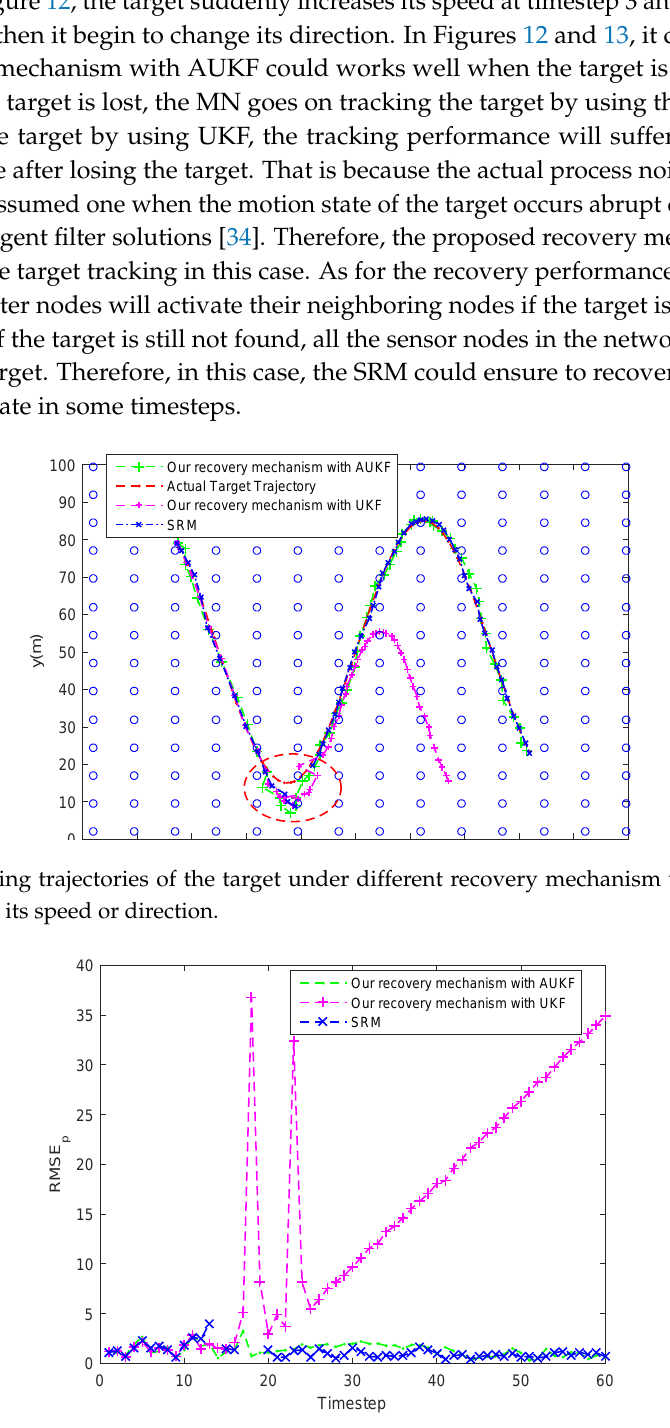
Figure 13. Tracking errors ( RMSE p ) at each timestep under different recovery mechanism when the target suddenly change its speed or